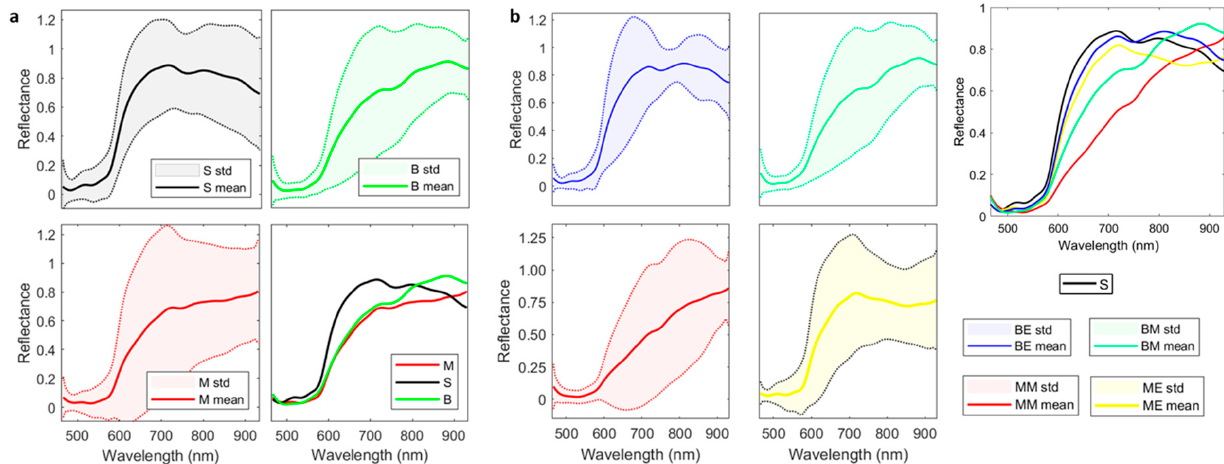
Figure 6. Mean and standard deviation (std) of the spectral signatures of the HS dataset. ( a ) Spectral signatures of skin, Benign and Malignant; ( b ) Spectral signatures of benign epithelial and melanocytic and malignant epithelial and melanocytic. S: Skin, B: Benign; M: Malignant; BE: Benign epithelial; BM: Benign melanocytic; ME: Malignant epithelial; MM: Malignant melanocytic. Supplementary Materials: The following supporting information can be downloaded at: https:// Binary classification performance of the four different approaches for discriminating epidermal lesions using HIS. Table S3: Multilabel classification performance of the four different approaches for discriminating epidermal lesions using HIS. Table S4: Binary segmentation performance of the four different approaches for segmenting epidermal lesions using HSI, including the skin class. Table S5: Multilabel segmentation performance of the four different approaches for segmenting epidermal lesions using HIS. Methods SM: Performance evaluation